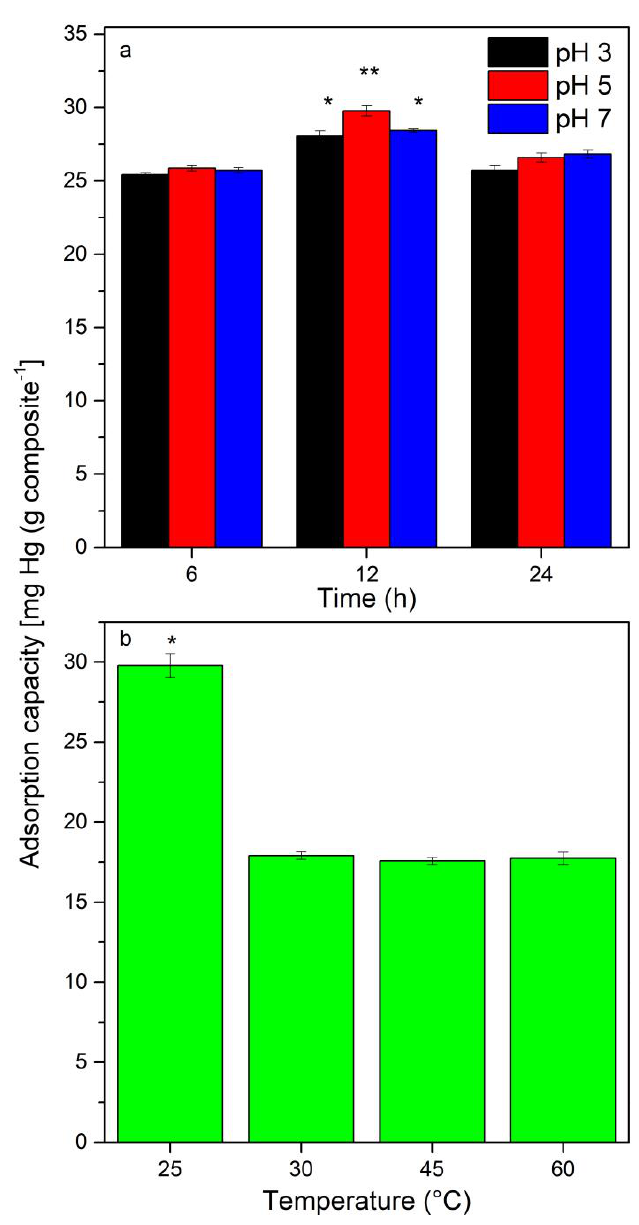
Figure 3. Adsorption capacity of mercury with the Fe 3 O 4 @ Sargassum @EDTA ( a ) at pH 3 (black), 5 (red), and 7 (blue) for 24 h, 25 °C; and ( b ) at different temperatures for 12 h at pH 5 (mean ± SD, n = 3). * Statistical difference between treatment p > 0.05. ** Statistical difference between groups p >